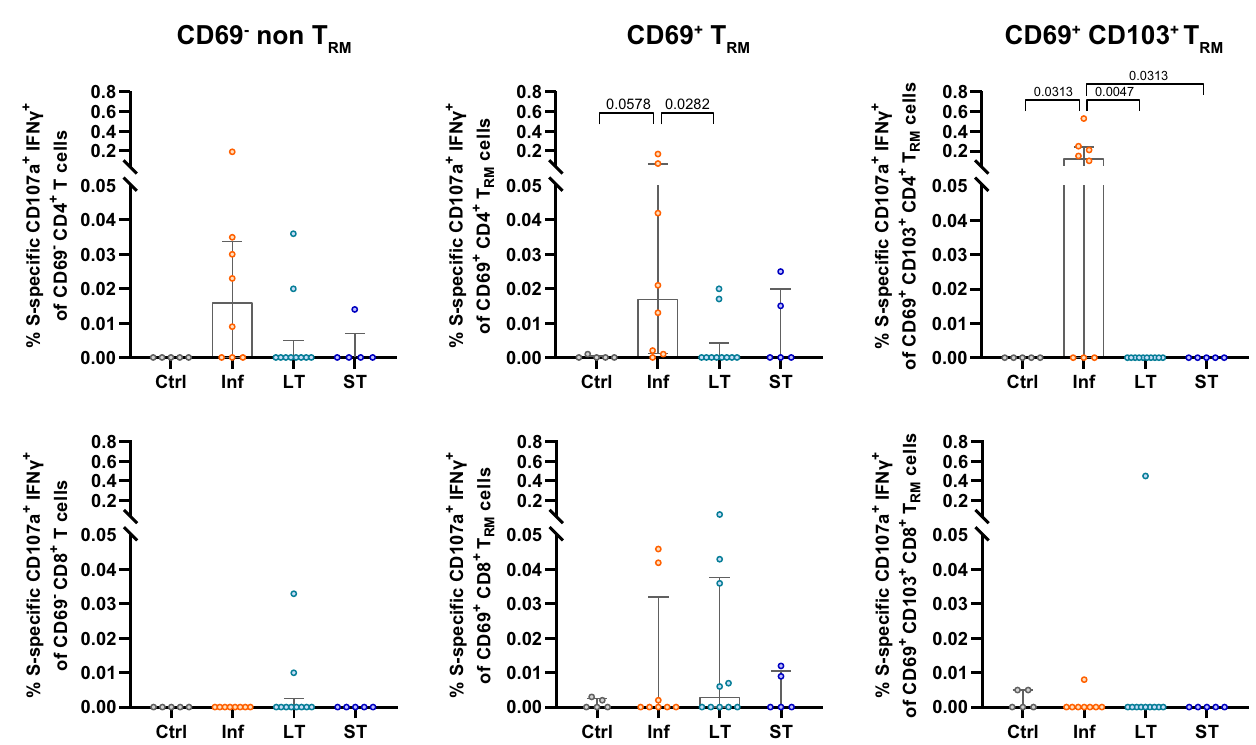
Fig.6|FrequencyofpolyfunctionalTcellresponsesagainstspikewithatissue- resident phenotype in the lung. Comparison of the net frequency of S-speci fi c polyfunctional CD107a + IFN γ + cells within lung CD4 + (upper) and CD8 + (lower) (non-) tissue-resident cell subsets (CD69 - non-T RM , CD69 + T RM , and CD69 + CD103 + T RM cells) for each of the four patient groups after exposure of single-cell lung suspensions to S-peptide pools. Data in bar graphs are shown as median±IQR,